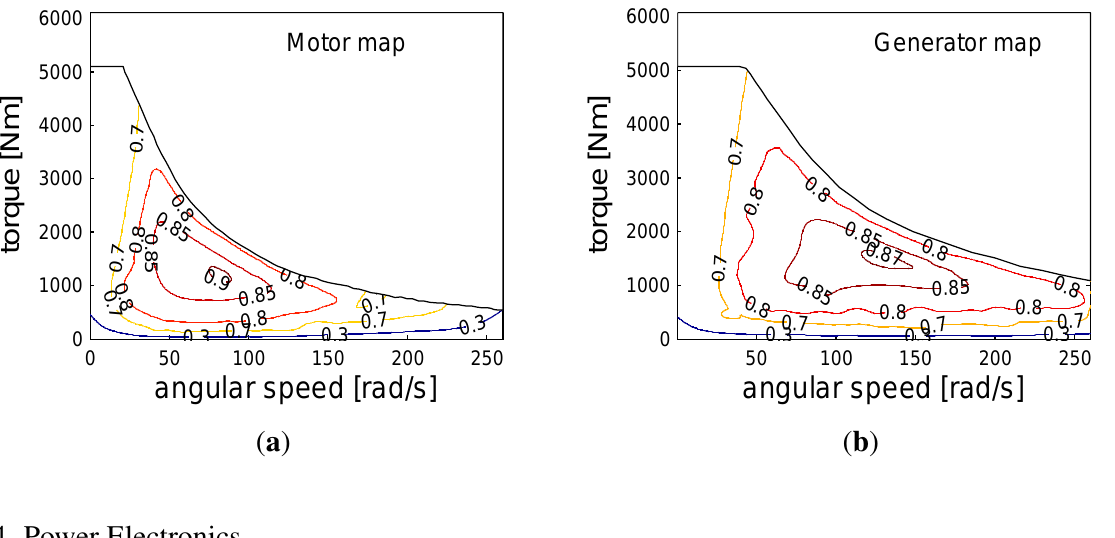
Figure 2. Efficiency map of the induction ( a ) motor and ( b )